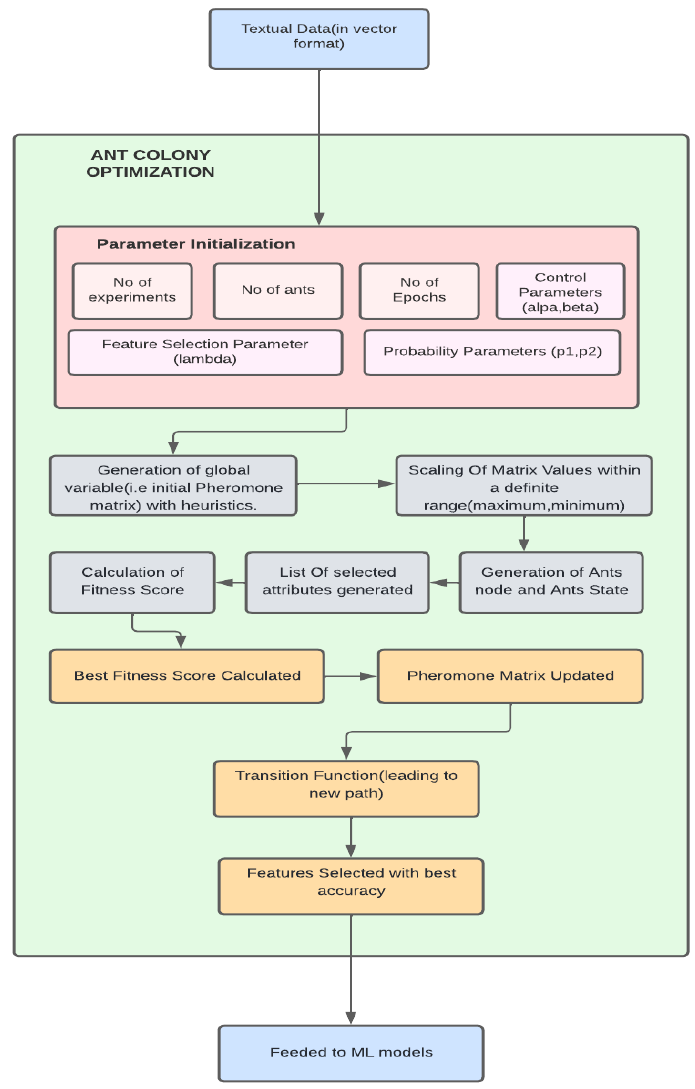
Figure 9. Ant Colony Optimization architecture for feature selection.